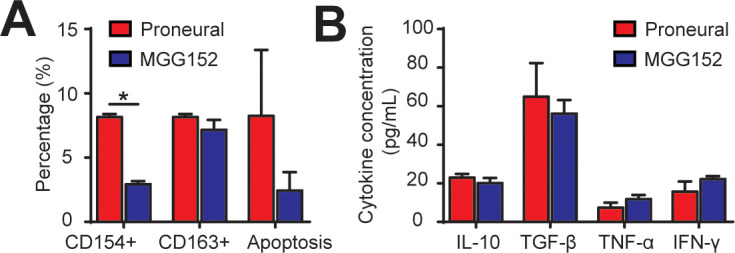
Comparison of cellular and cytokine conditions of IDH-mutant and IDH-wildtype GBM tumor cells.(A) Quantified ratios of CD8+CD154+ cells, CD68+CD163+ cells and caspase-3/7+ apoptosis cells in MGG152 IDH-mutant and proneural GBMs. The PN GBM result represents the mean of three PN GBM cells (GBML20, GBML109, and GS7-11). Note that percentages of CD163+ and apoptosis cells were comparable between the MGG152 and PN GBMs. (B) Comparable concentrations of both pro-inflammatory (TNF-α, IFN-γ) and immunosuppressive (TGF-β and IL-10) cytokines in both cell types. Error bars represent ± s.e.m. p-Values were calculated using the unpaired two-tailed Student’s t-test. *, p<0.05.